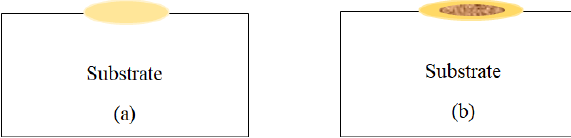
Figure 11a views the polished sample; this